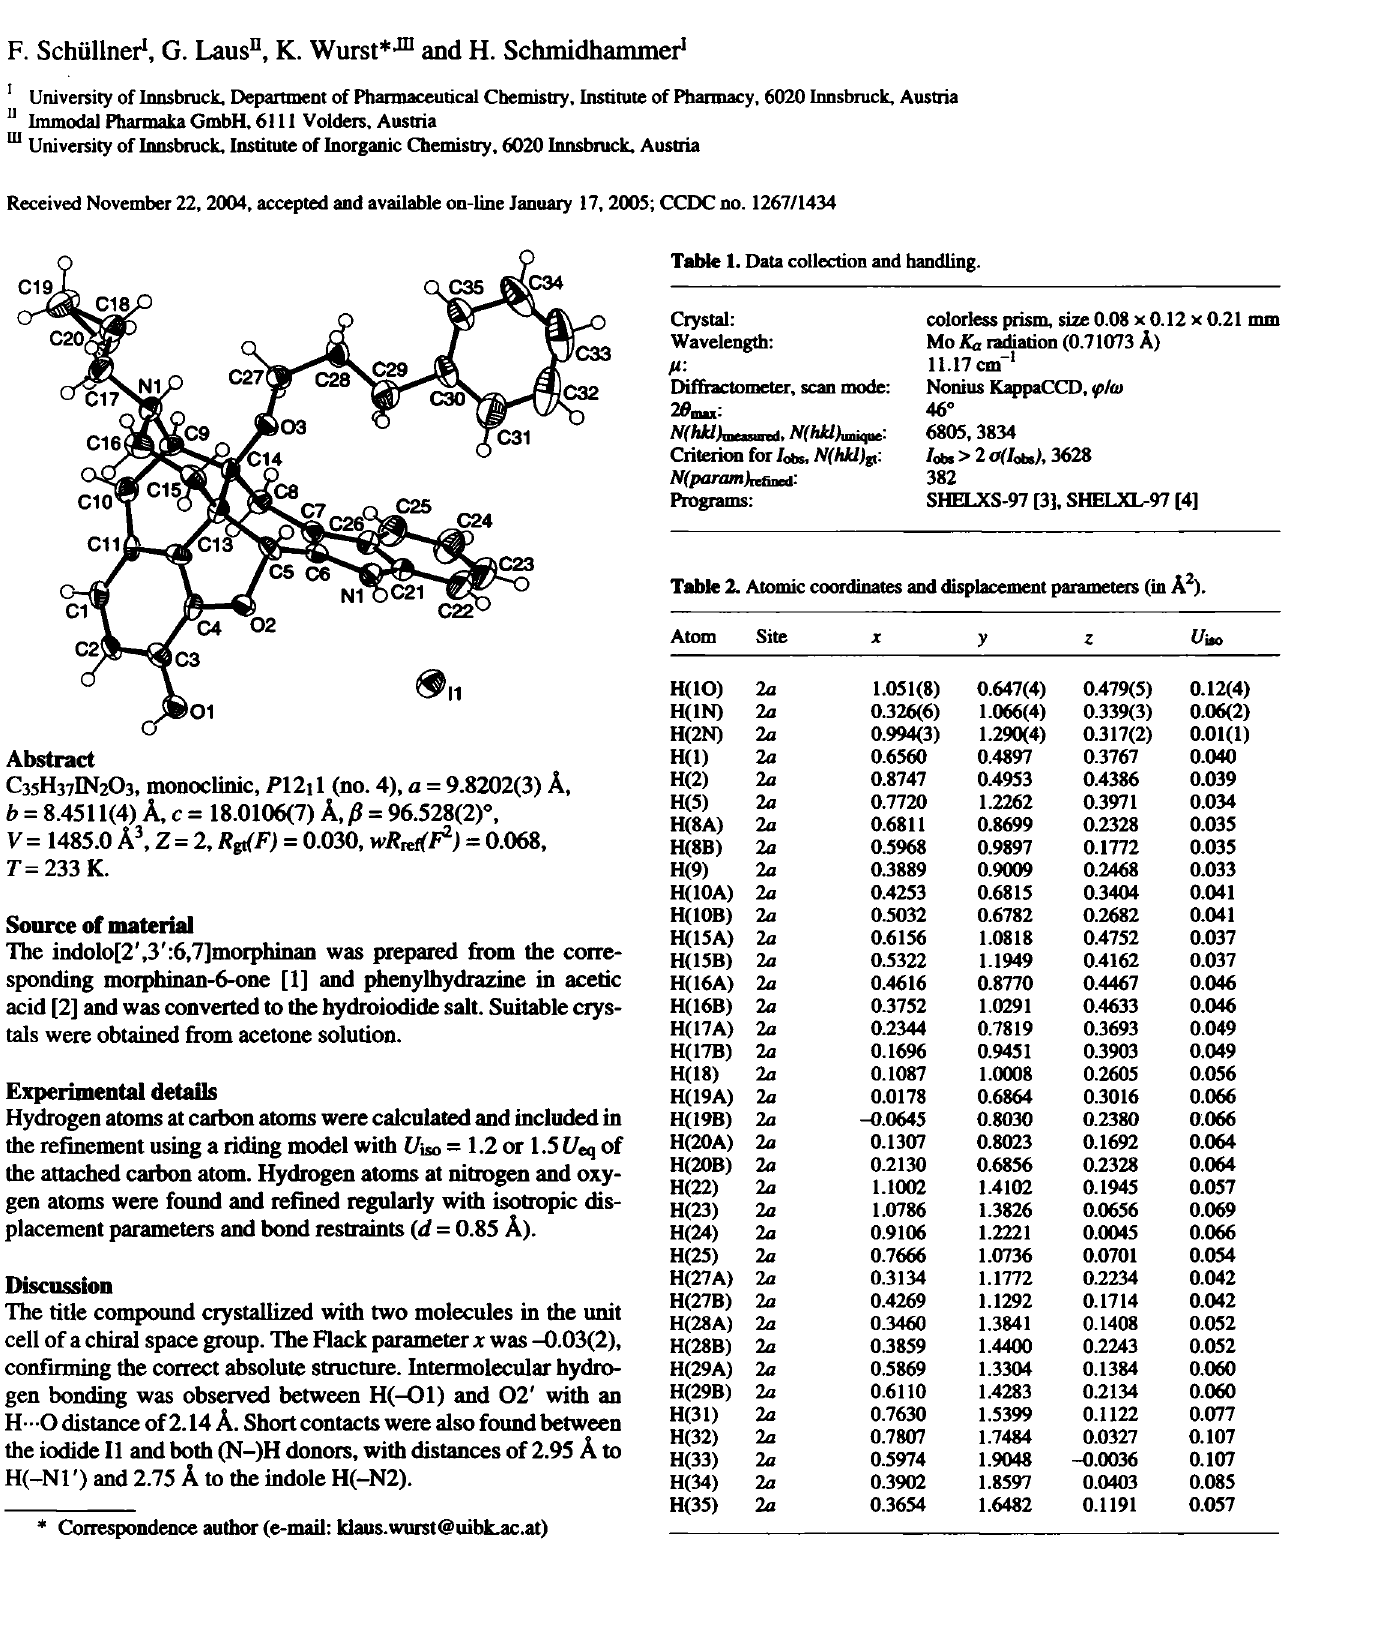
Table 2. Atomic coordinates and displacement parameters (in A 2